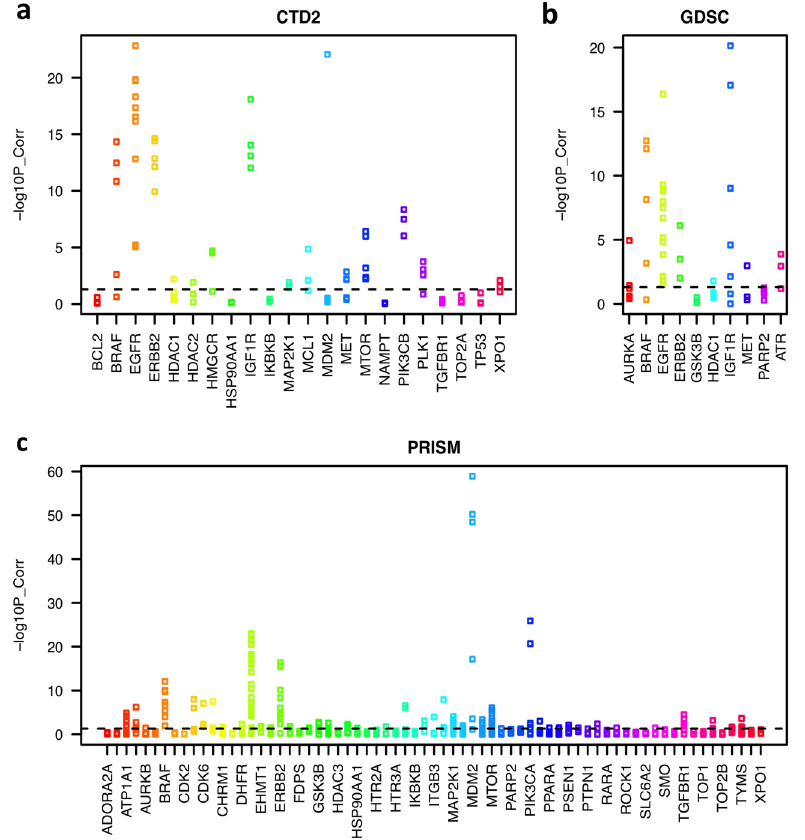
Figure 2. Strip charts of the correlation between cell viabilities upon drug treatment and the silencing of the primary target across the same cancer cell lines. The y-axis represents the negative log10 p-value of the correlation.